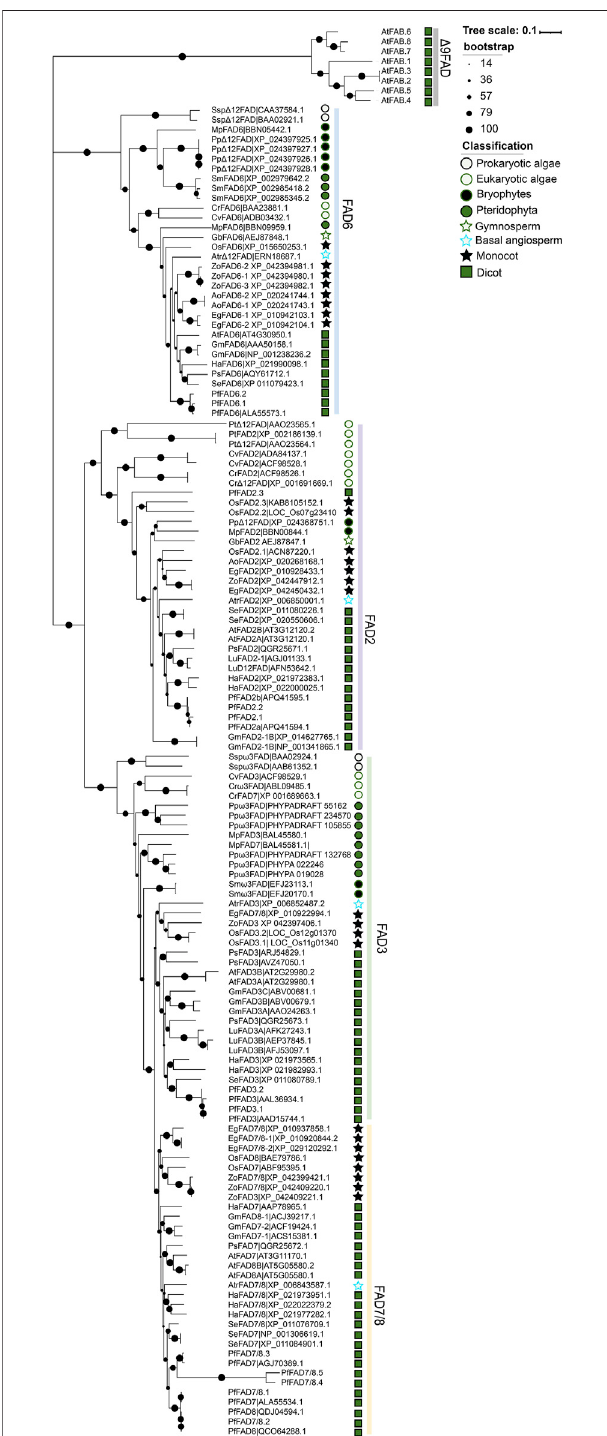
FIGURE 4 | Evolutionary analysis of PUFA desaturases. Δ 9 desaturases from A. thaliana was used as the outgroup. The tree was constructed using MEGA X by the neighbor-joining method with 1,000 bootstraps. Detailed information on prokaryotic algae, eukaryotic algae, bryophytes, pteridophytes, and monocot and dicot plants is shown in Supplementary Table S1